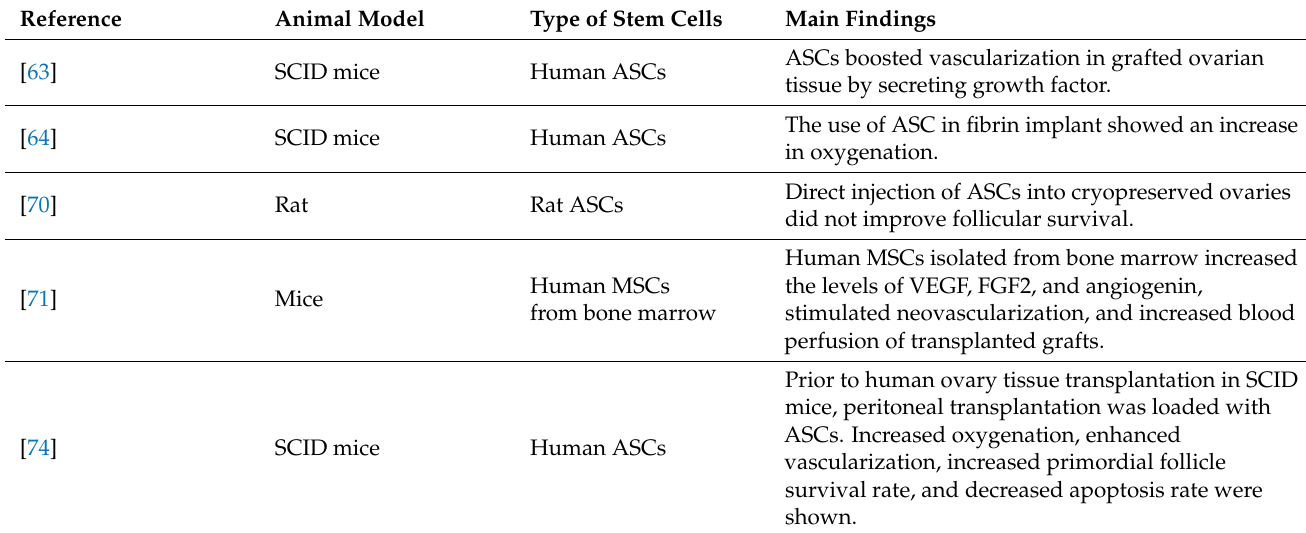
Table 1. Articles of stem cells in ovarian tissue cryopreservation and